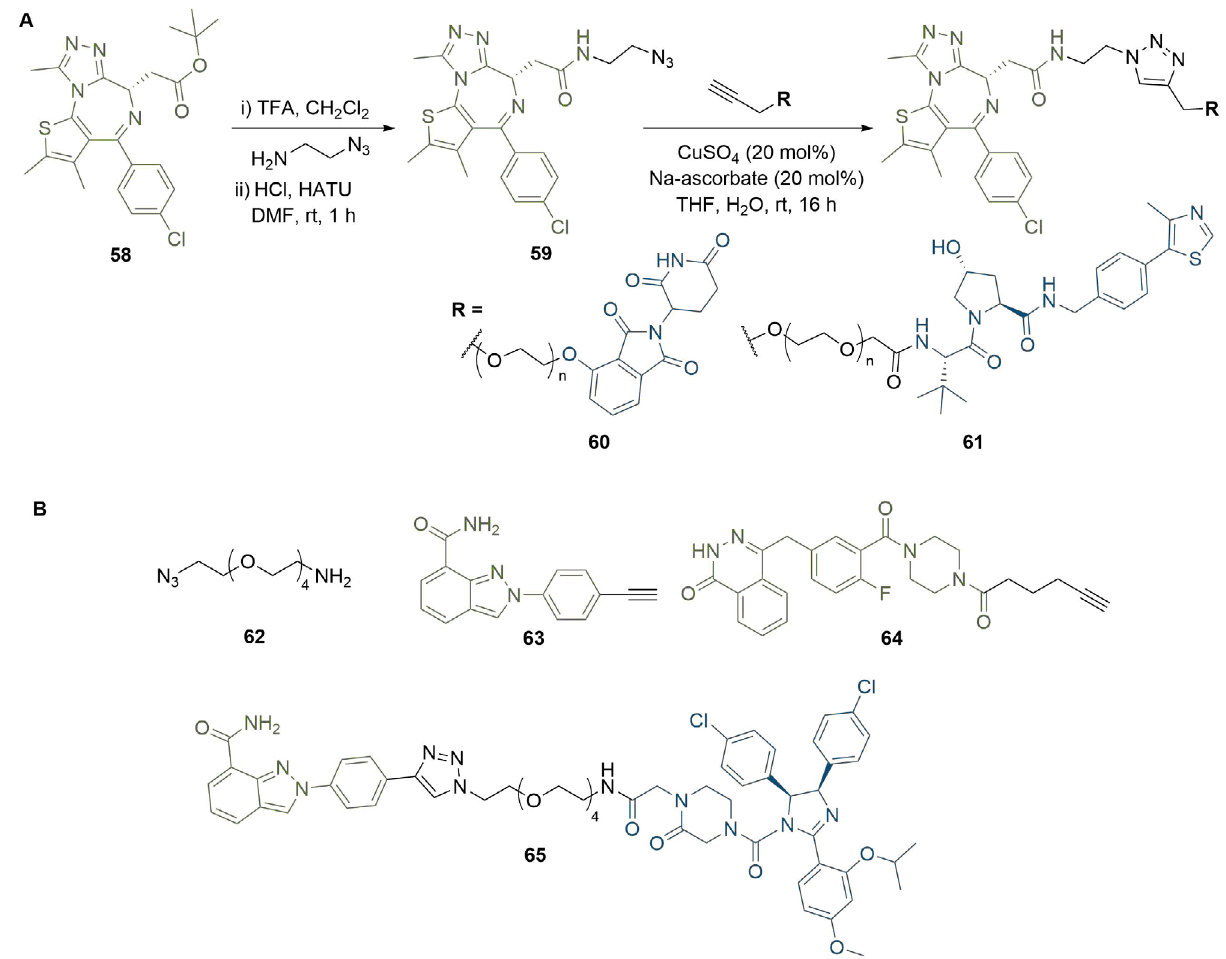
Explor Target Antitumor Ther. 2020;1:273-312 |